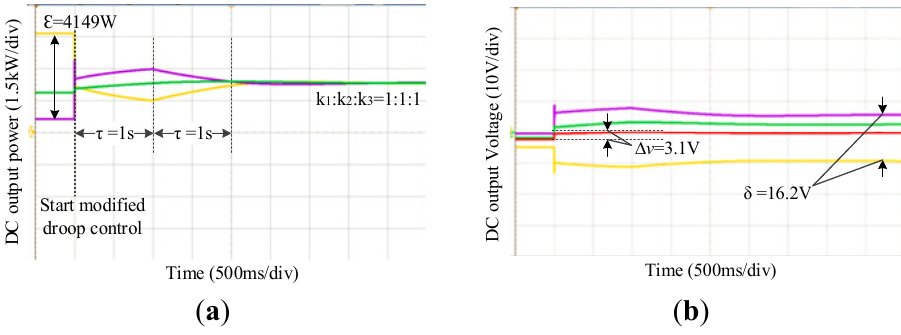
Figure 8. Modified control method test result for Case 3 in the mesh configuration. ( a ) Power sharing accuracy; ( b ) Voltage restoration.